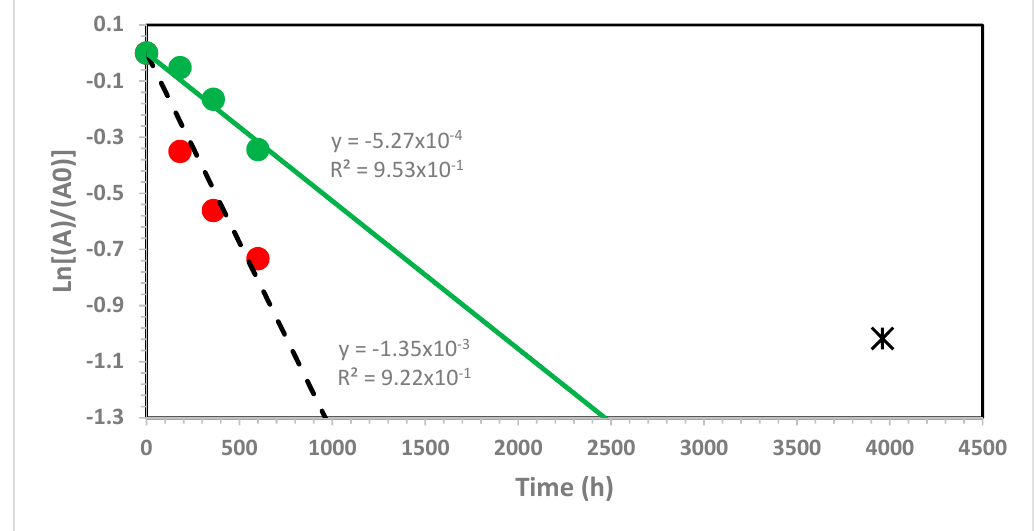
Figure 7. Kinetics of dyes bleaching inside the PLLA film (30 μ m thick) exposed to ozone; ozonolysis of SY93 with k dec = 1.35 × 10 − 3 h − 1 (absorbance at 438 nm, red dots and black dotted line); the asterisk shows the value of Ln[(A/A 0 ) 438 ] after 4000 h exposure to ozone and not included in the determination of the SY93 ozonolysis rate constant; ozonolysis of PB16 with k dec = 5.27 × 10 − 4 h − 1 (absorbance at 711 nm, green dots and line).